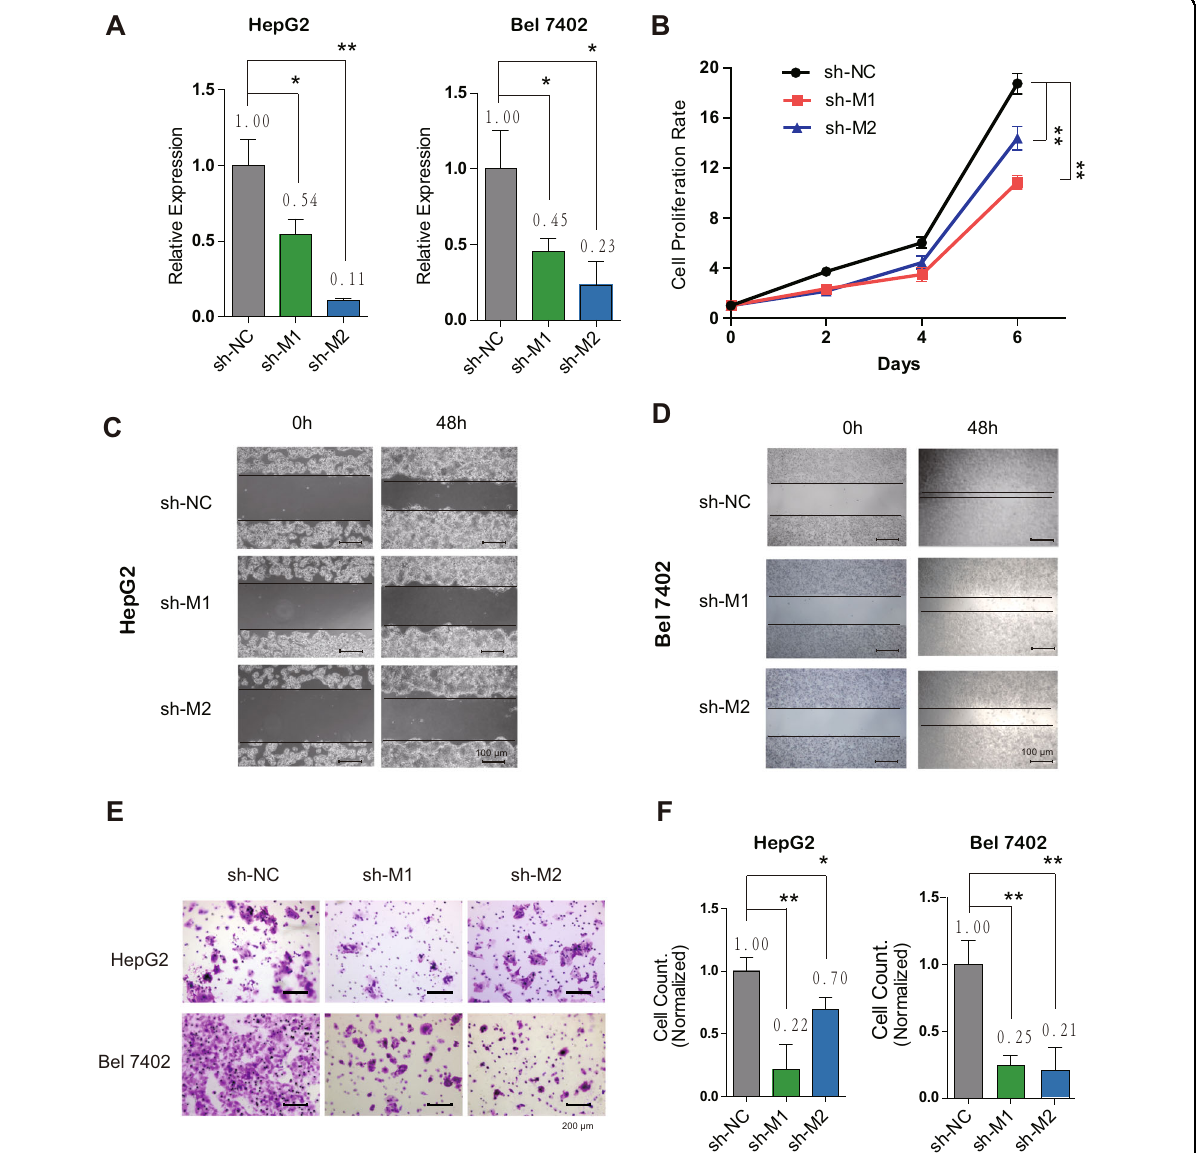
Fig. 4 MALAT1 promotes HCC cell proliferation and metastasis in vitro. A The expression of MALAT1 in HepG2/Bel7402 + shNC/shMALAT1-1/ shMALAT1-2 stable cell lines were measured by real-time RT-PCR. B CCK8 assay was performed to detect the effect of MALAT1 on cell proliferation at day 0, 2, 4, and 6. Wound healing assays were performed in ( C ) HepG2 and ( D ) Bel7402 NC/MALAT1 knockdown stable cell lines. Movement of cells into wound was shown at 0 and 48 h post scratch. Scale bar represents 100 μ m. E Transwell matrigel invasion assay showing the effect of MALAT1 knockdown on the invasive activity of HepG2 or Bel7402 stable cells. Scale bar represents 200 μ m. F The graphics presents the number of invaded cells, normalized to NC group. Quantitative data were represented as mean ± SD. * P < 0.05, ** P <